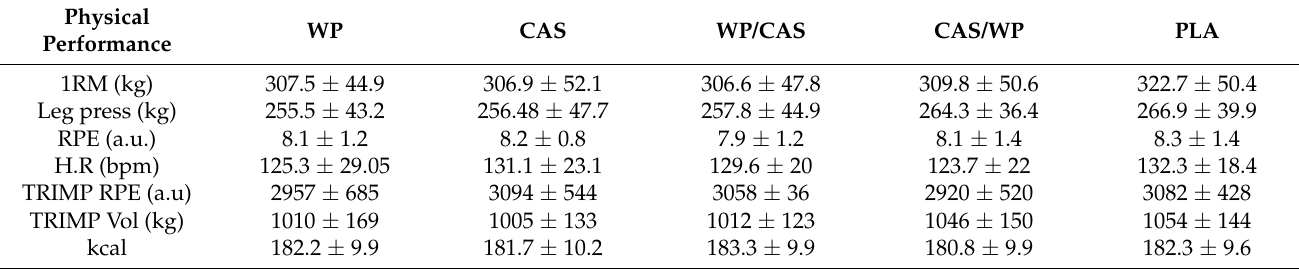
Table 3. Participant characteristics and exercise performances during each training